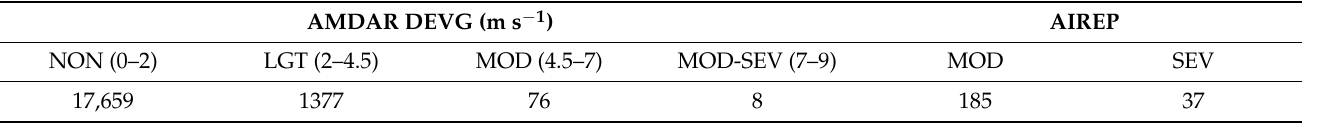
Table 2. Absolute frequency of DEVG and AIREP data. The turbulence observations total 19,342